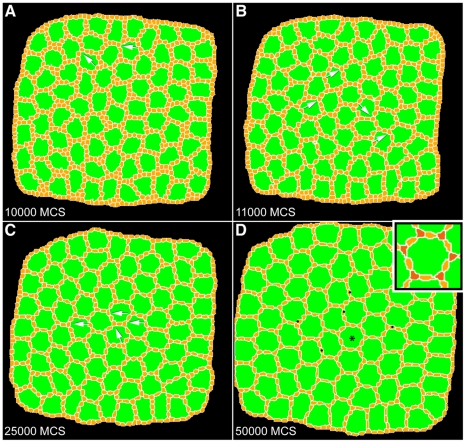
Simulation of wild-type development.(A) Image captured at 10,000 MCS exhibited numerous ectopic cells and few 3°s (arrows). Cell death has not yet been initiated. (B) Image from 11,000 MCS. Cell death has been initiated and there are fewer cells and more 3°s (arrows). (C) Image from 25,000 MCS. There are fewer cells and most central ommatidia have cells in the 3° locus (arrows). (D) Image from 50,000 MCS. There are a few extra 2°-like cells (•) and all central ommatidia show a complete complement of 3°s. Asterisk labels the ommatidium shown in inset with 3°s colored red.